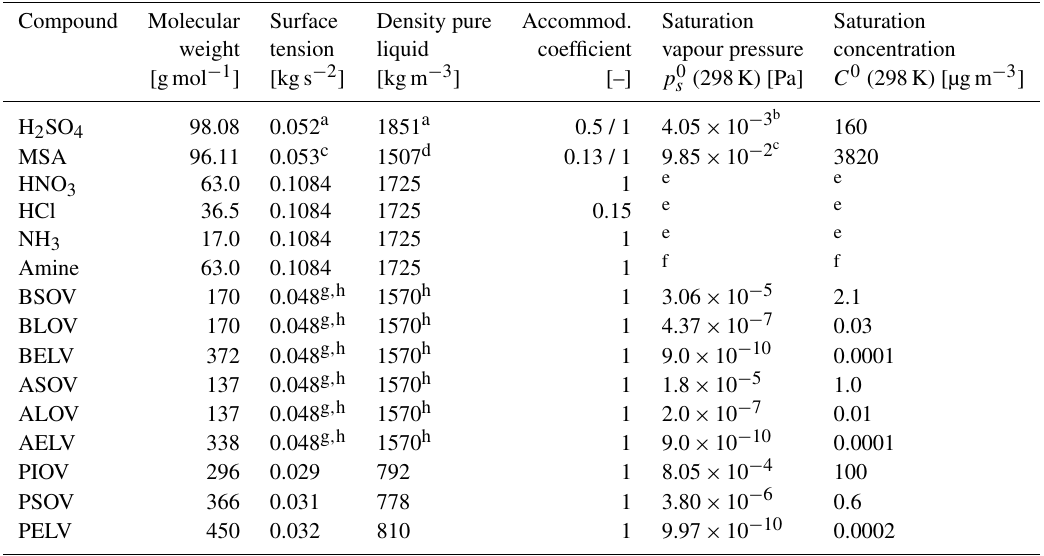
Table 2. Molecular properties of the condensing vapours. Saturation concentration C 0 is provided by the model user for the lumped organic compounds.